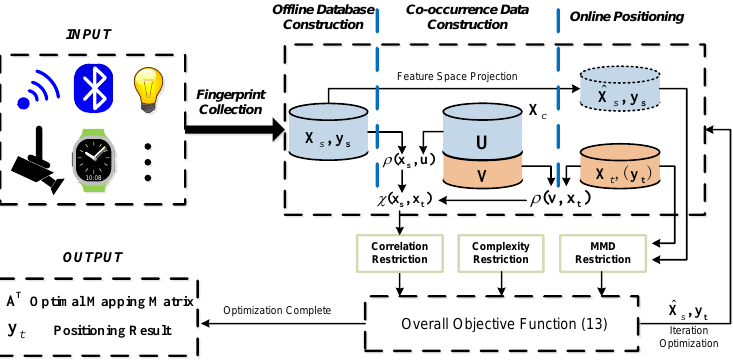
Figure 1. Overall architecture of the proposed